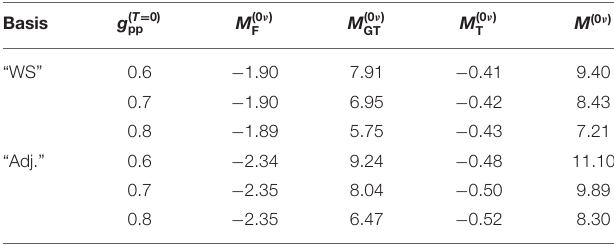
The matrix elements are computed in different single-particle bases with different values of g pp .